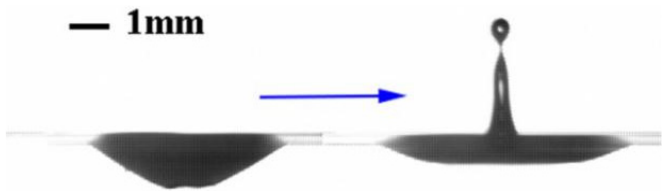
Figure 8. Jetting produced by bubble rupture.